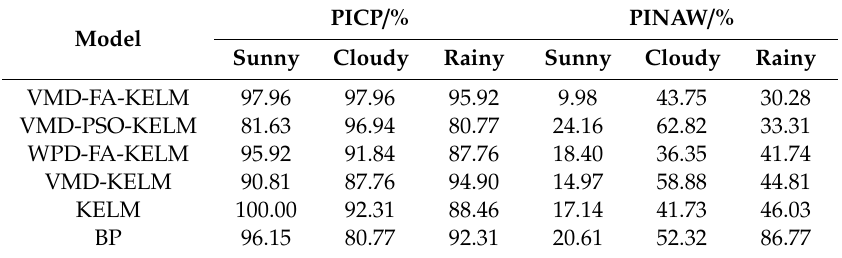
Table 7. Prediction interval indices of di ff erent optimization algorithms under the 90% confidence level.